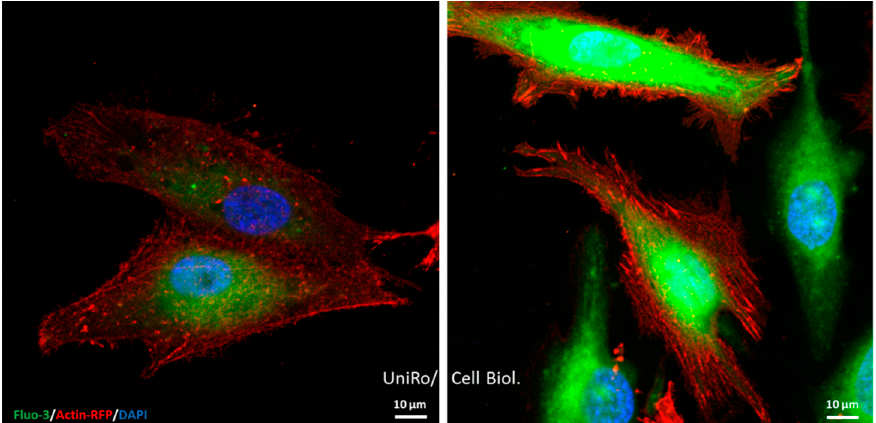
Figure 2. Basal calcium ion levels (green) in living MG-63 osteoblasts (red for actin, blue for nucleus) 24 h on planar Ti, either uncoated ( left ) or coated with a nanolayer of the plasma polymer (PPAAm, 480 s gross) ( right ). Note that on PPAAm, the intracellular basal Ca 2+ ion level is elevated, indicating higher cellular activity. Live-cell staining: 50,000 cells/cm 2 Ti wafer in DMEM with 10% FCS, staining with 20 µL BacMam 2.0 reagent (red) (actin-RFP, Life Technologies Corporation, Eugene, Oregon, USA) at 37 °C, 5 µM calcium indicator Fluo-3/AM (green) (Life Technologies Corporation) [27,28], and 1:1000 Hoechst 33342 (blue) (Thermo Fisher Scientific, Waltham, Massachusetts, USA) in isotonic HEPES buffer. Confocal laser scanning microscopy (LSM 780, Carl Zeiss Microscopy GmbH, Jena, Germany) with a plan-apochromat 63× oil immersion objective (Carl Zeiss, 1.40. Oil DIC M27), excitation at 405, 488, and 561 nm; scale bars 10 µm.